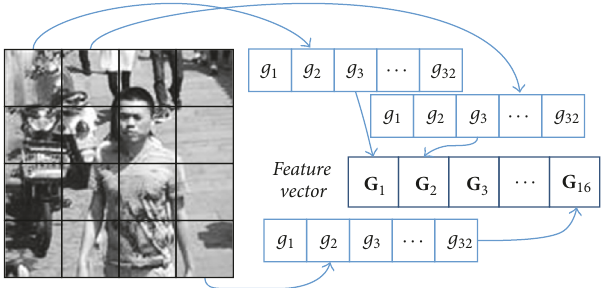
Figure 6: GIST feature extraction diagram.